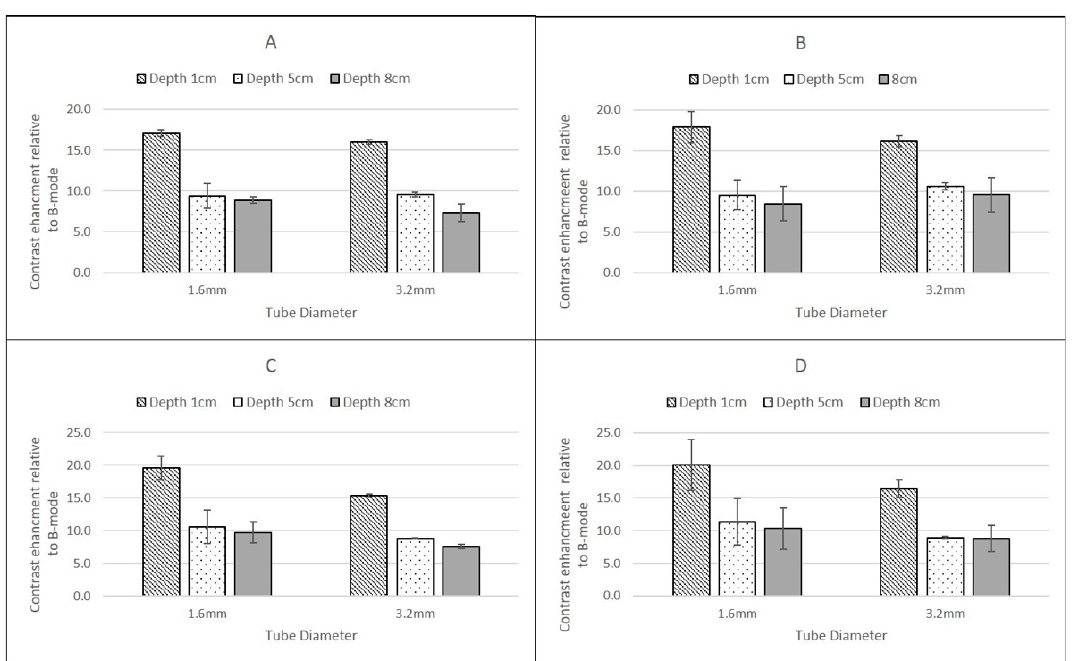
Figure 5. Ratio of backscatter signal in contrast-specific imaging mode to B-mode using a Philips iU22 L9-3 probe for ( A ) SonoVue at a flow rate of 0.25 mL/s; ( B ) DEFINITY ® at a flow rate of 0.25 mL/s; ( C ) SonoVue at a flow rate of 1.5 mL/s; ( D ) DEFINITY ® at a flow rate of 1.5 mL/s. Error bars are standard deviations.